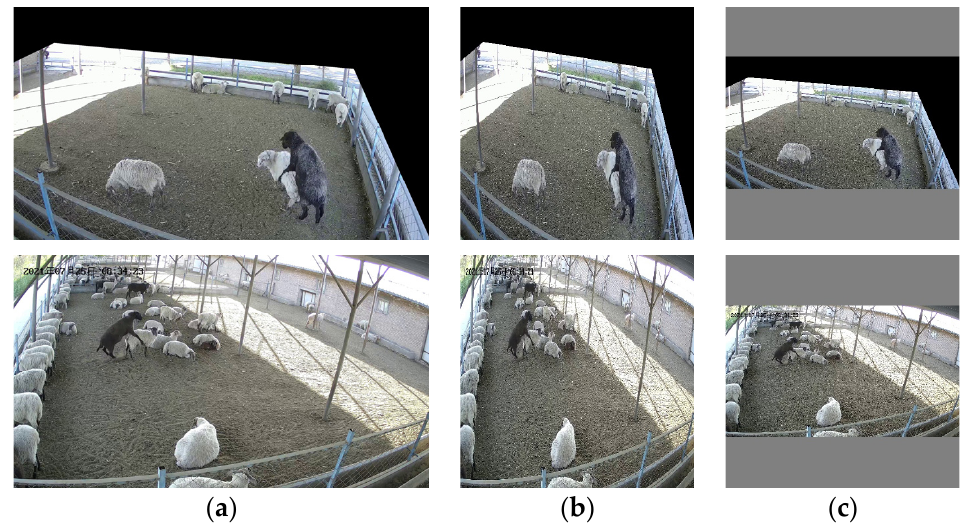
Figure 7. Picture resolution adjustment: ( a ) Original picture; ( b ) Direct adjustment; ( c ) Maintaining 283 adjustment of aspect ratio. adjustment of aspect